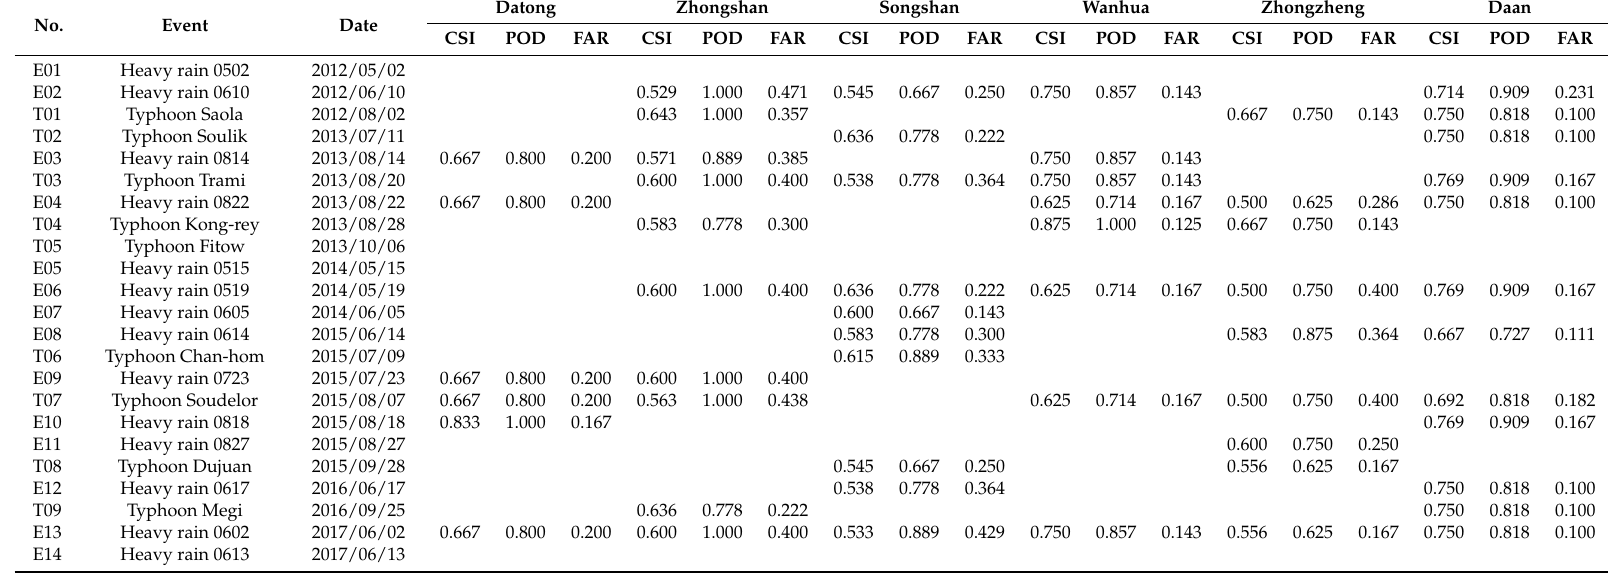
Table 9. Performance of cross test as evaluated by the criteria POD, FAR and